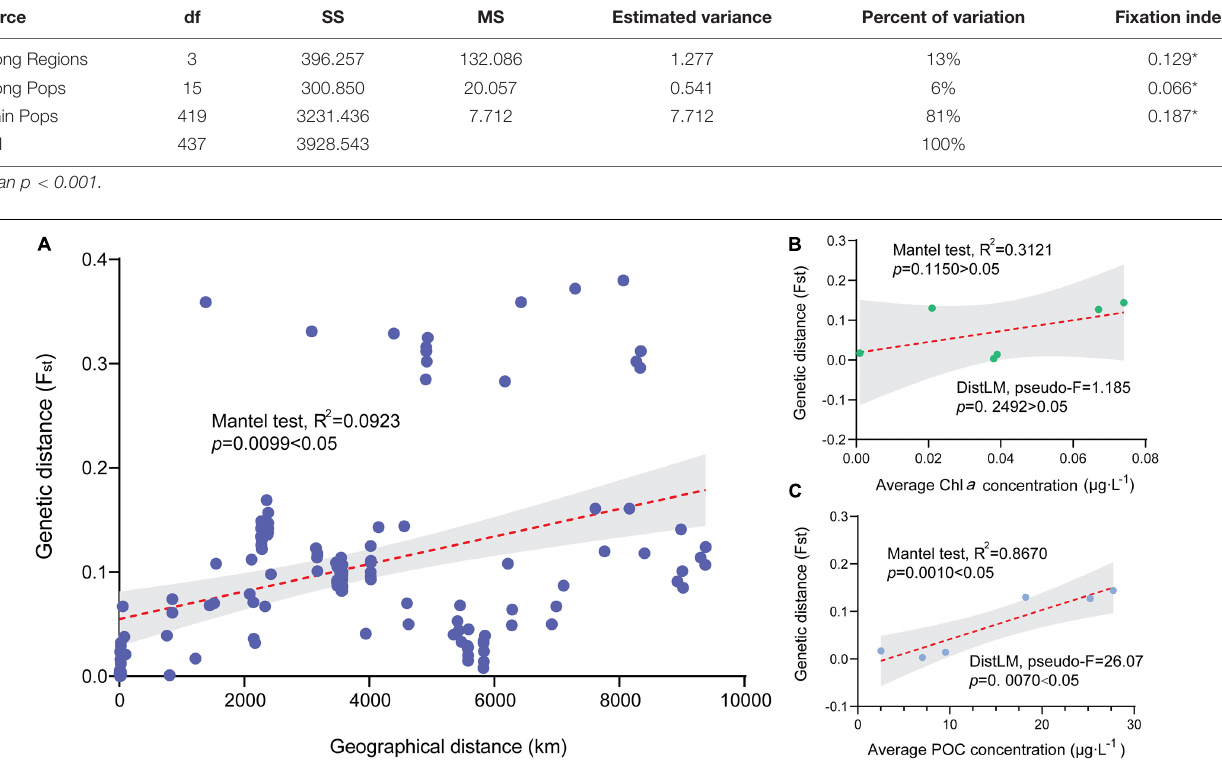
FIGURE 5 | Correlations between genetic differentiation of crown-of-thorns starfish (COTS) populations and geographic and environmental factors. (A) There was a significantly positive relationship between F st values of COTS populations and geographic distance in the Pacific Ocean (km; Mantel test, R 2 = 0.1347, p = 0.0099 < 0.05). (B) There were no significant associations between F st values of COTS populations and chlorophyll a concentration ( µ g · L − 1 ; Mantel test, R 2 = 0.3121, p = 0.1150 < 0.05) in the South China Sea. (C) There was a significantly positive correlation between F st values of COTS populations and particulate organic carbon concentrations ( µ g · L − 1 ; Mantel test, R 2 = 0.8670, p = 0.0010 < 0.05) in the South China